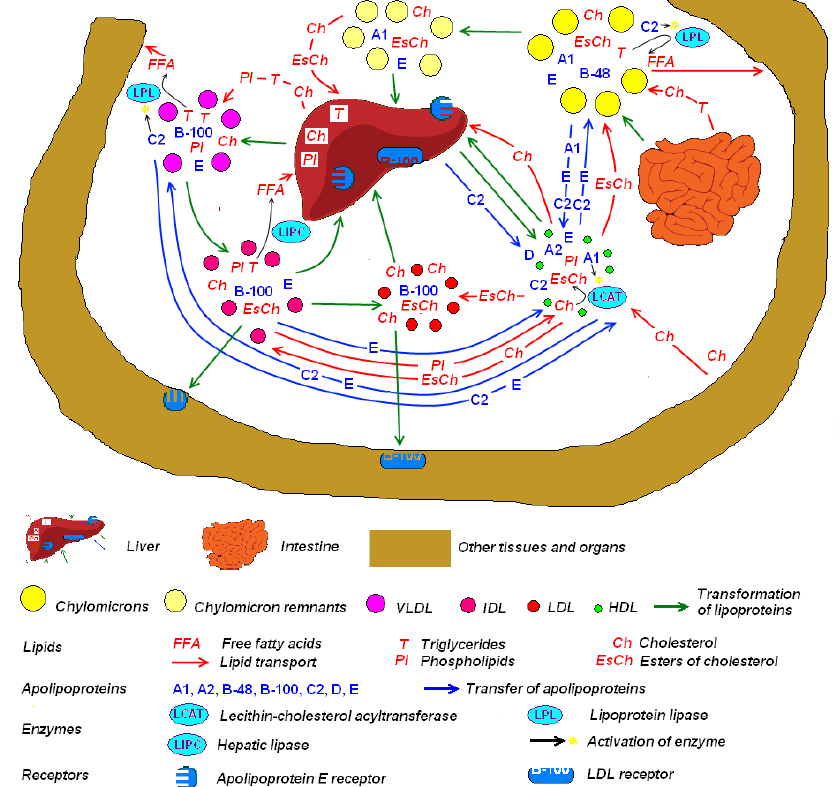
Figure 4. Lipid transport and metabolism in the human body. Apolipoproteins (e.g., A1, A2, B- 48, B-100, C2, D, and E) bind water-insoluble lipids to form water-soluble lipoproteins such as chylomicrons, very low-density lipoproteins (VLDL), low-density lipoprotein (LDL), and high- density lipoprotein (HDL) to allow the transport of lipids (e.g., cholesterol, triglycerides) through the bloodstream. The process of lipoprotein formation is mediated by enzymes such as lecithin- cholesterol acyltransferase (LCAT). Upon arrival in their target tissues, lipids carried by lipoproteins are broken down by enzymes such as lipoprotein lipase (LPL) in peripheral tissue and hepatic lipase (LIPC) in the liver. (Image adapted with permission from: Vtosha, CC BY-SA 3.0,